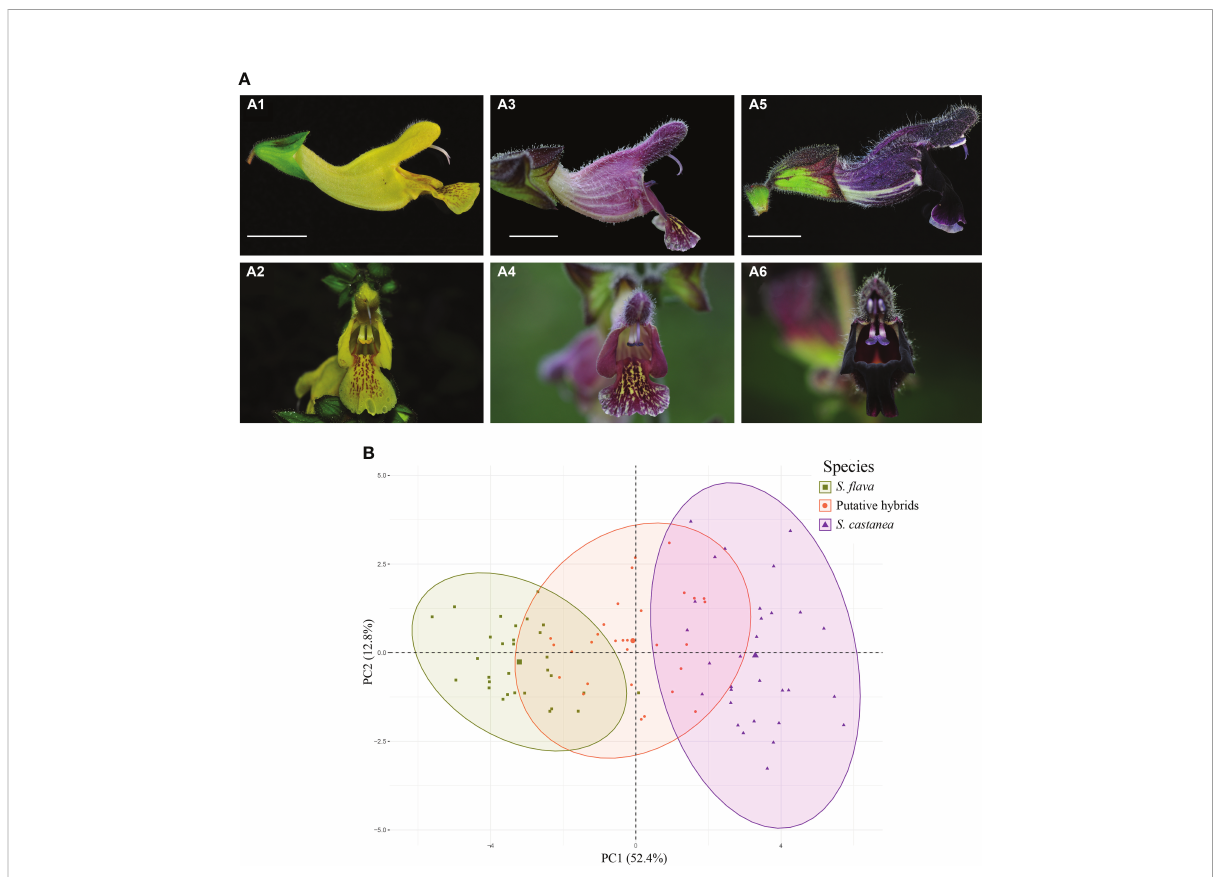
FIGURE 2 (A) Morphological differences between Salvia fl ava (A1 – A2), S . castanea (A5 – A6) and putative hybrid individuals (A3 – A4), and (B) PCA plot of fi rst two components based on data from the 16 quantitative morphological